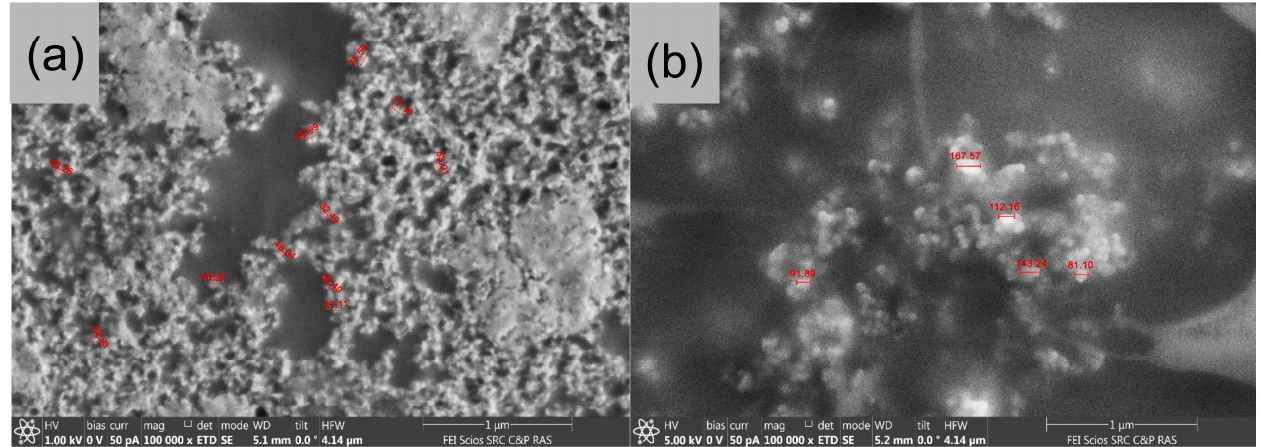
Figure 1. SEM-images of empty uncoated ( a ) and covered with 5 kDa chitosan ( b ) calcium phosphate (CaP) nanoparticles.